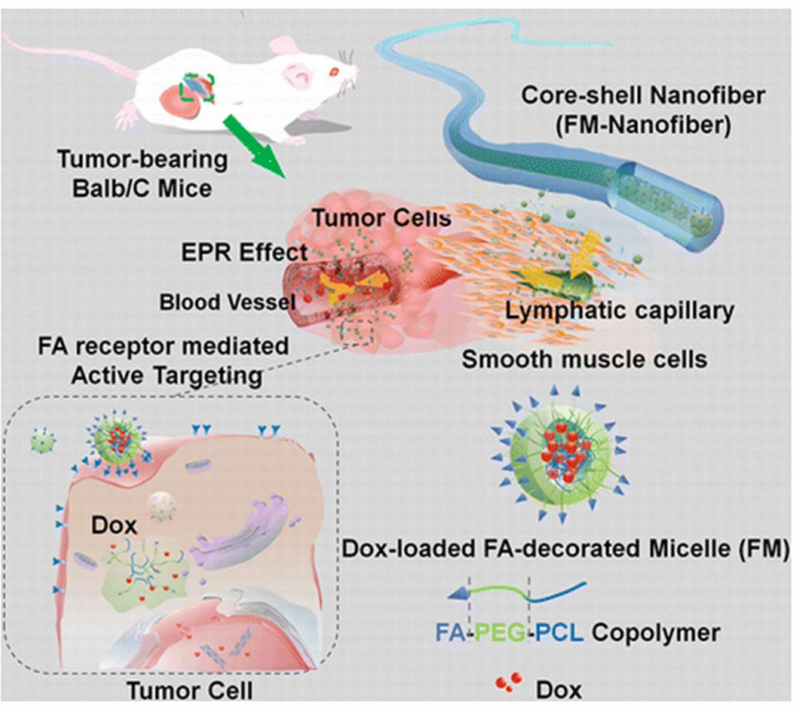
Figure 3. Coaxial electrospinning-prepared implantable Doxorubicin-loaded micelles in NFs for effective cancer therapy. Reprinted with permission from ref.